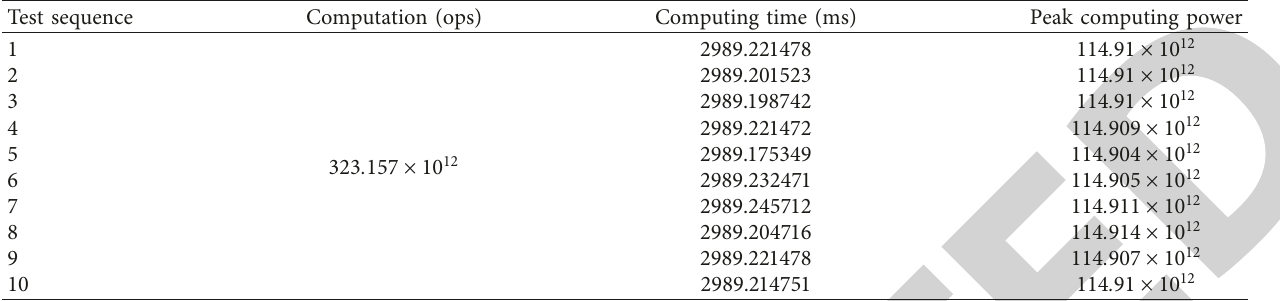
Table 1: Evaluation results in peak